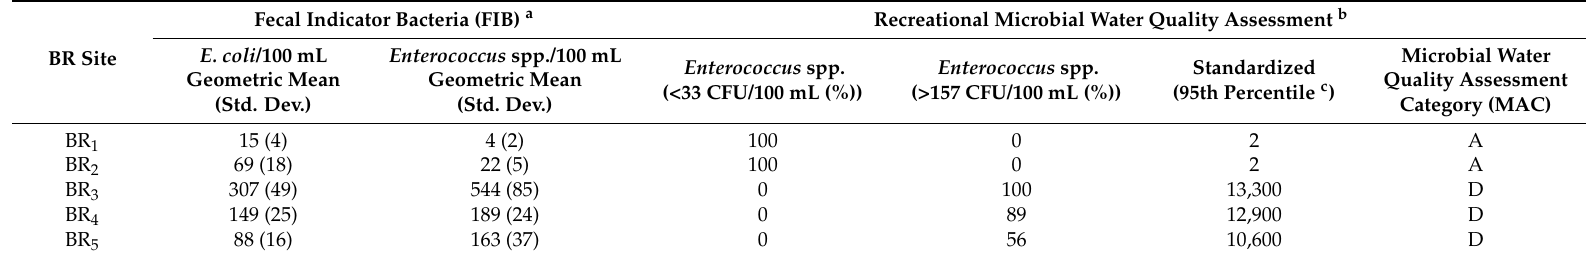
Table 4. Microbial water quality based on the various coliform counting methods. Values in the parenthesis indicate standard deviations ( n =